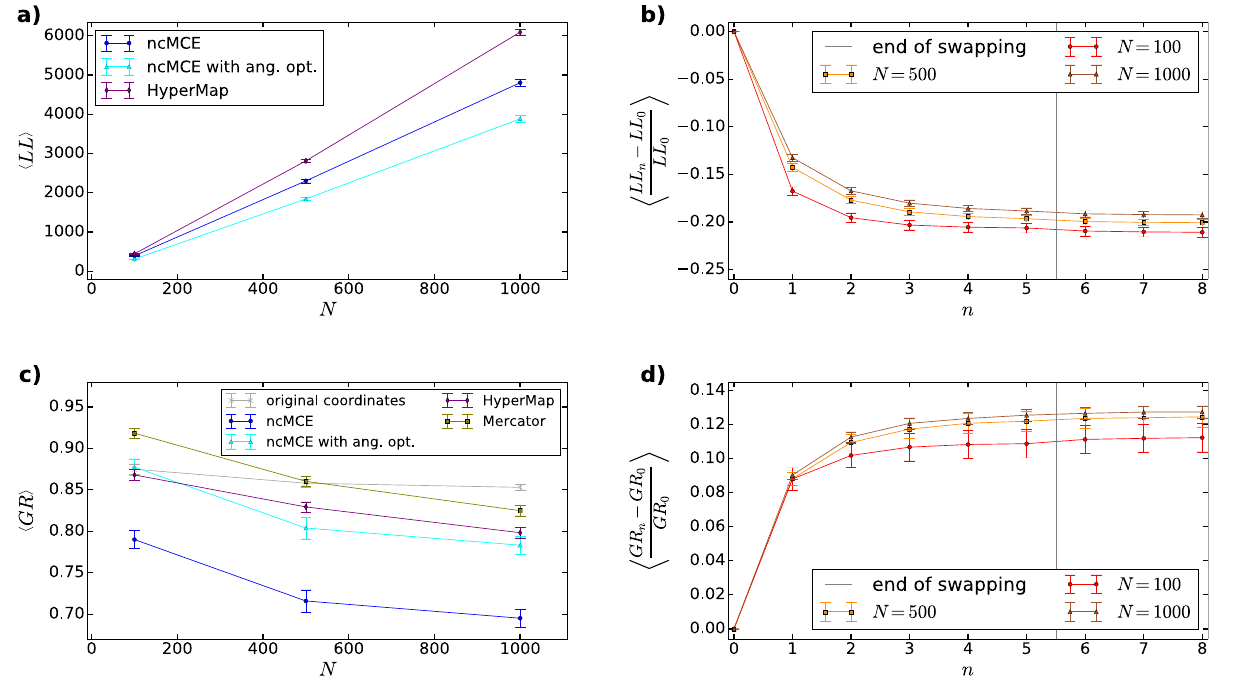
Figure 4. Embedding results for synthetic networks. ( a ) The average logarithmic loss < LL > and the corresponding 95% confidence interval (indicated by bars) as a function of the number of nodes N for 100 networks generated by the PSO model using ζ logarithmic loss over the subsequent rounds of iterations during the proposed angular optimisation of the ncMCE method. ( c ) The average greedy routing score < GR > and the corresponding 95% confidence interval (indicated by bars) as a function of the number of nodes N for the same synthetic data set as in panel ( a ). ( d ) The convergence of the greedy routing score as a function of the number of rounds n during our angular